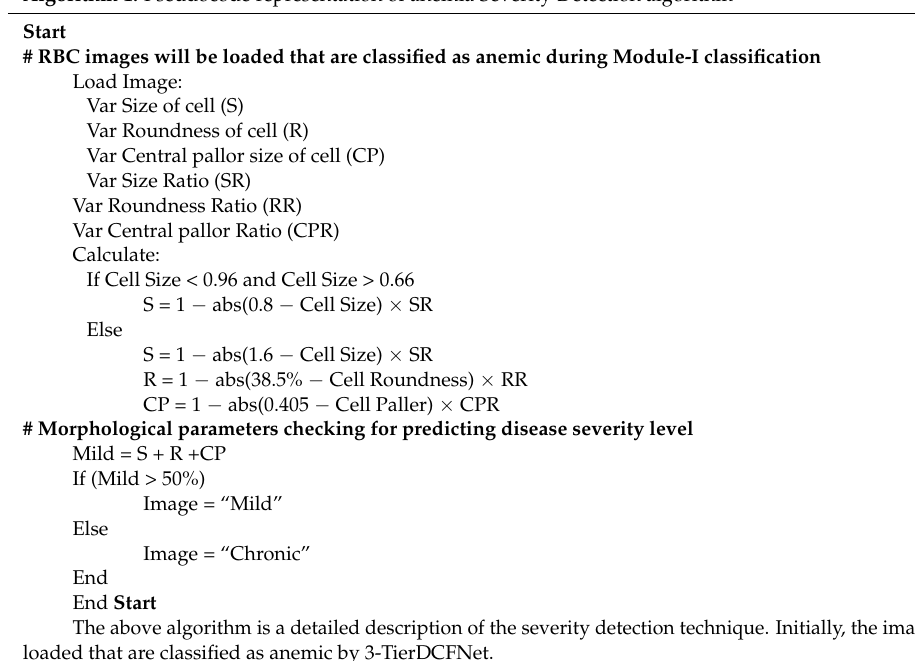
Algorithm 1. Pseudocode representation of anemia Severity Detection